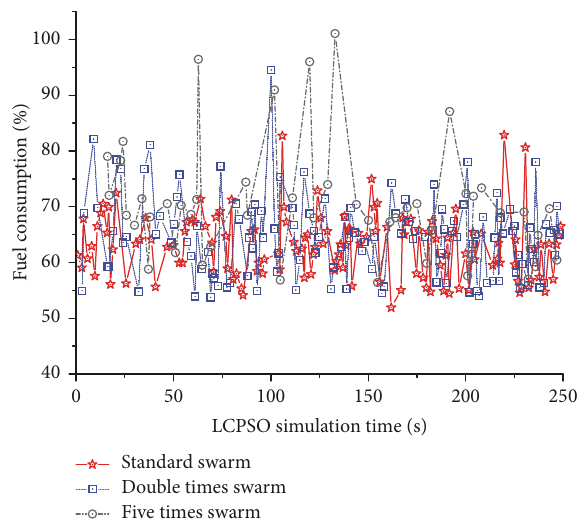
Figure 5: Result distribution with standard, double times, and five times